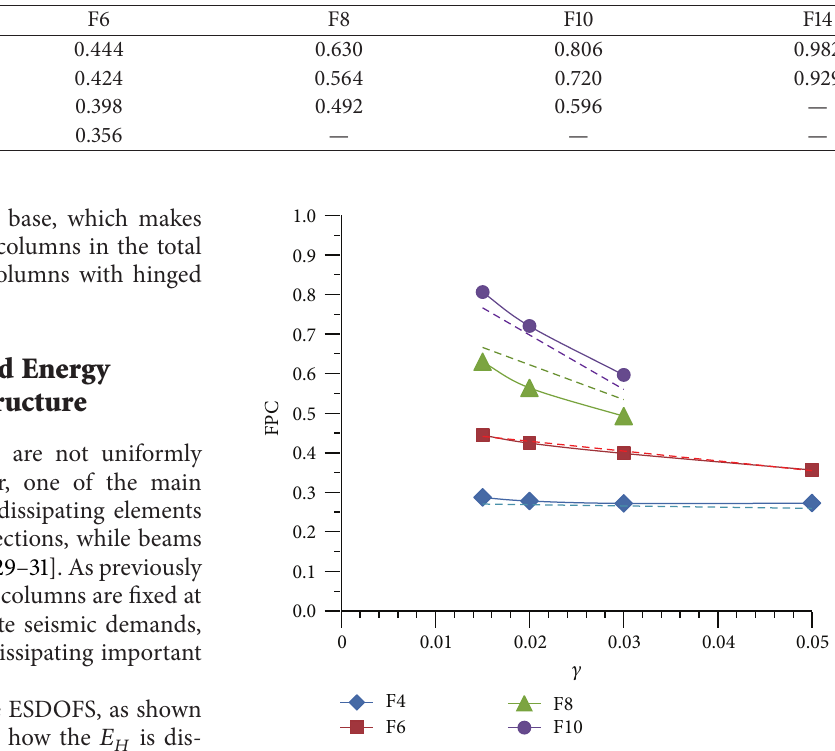
Figure 7: FPC as function of the